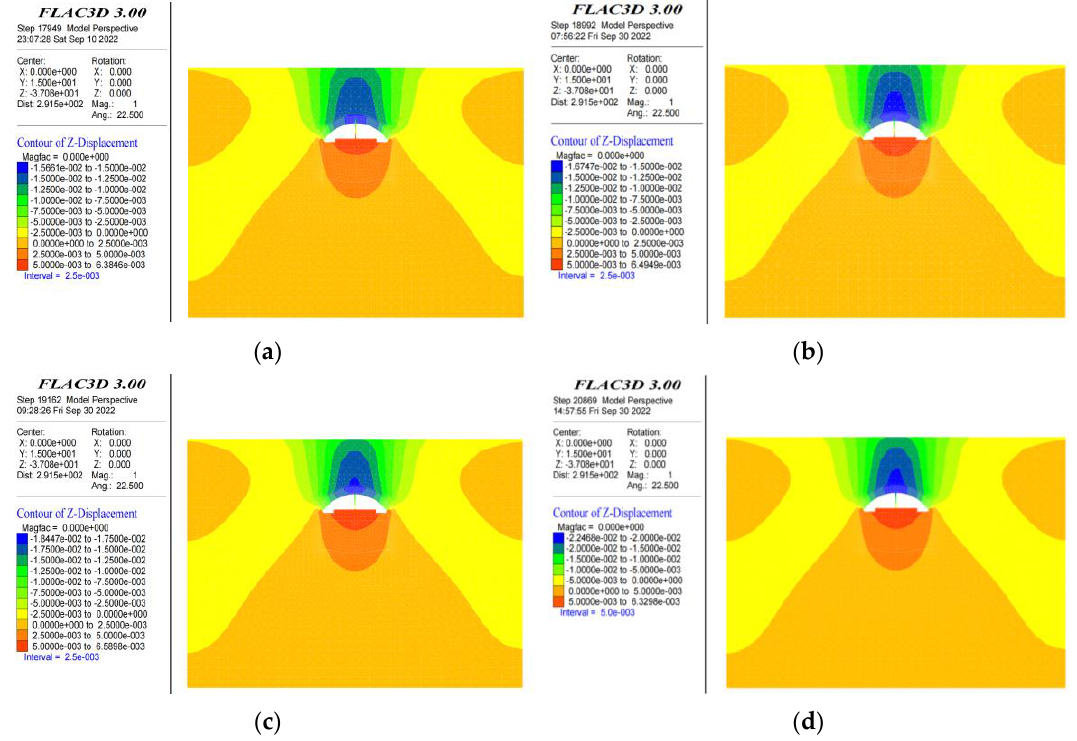
Figure 11. Vertical displacement cloud diagram of each demolished length: ( a ) dismantle 6 m; ( b ) dismantle 12 m; ( c ) dismantle 18 m; ( d ) dismantle 24 m.